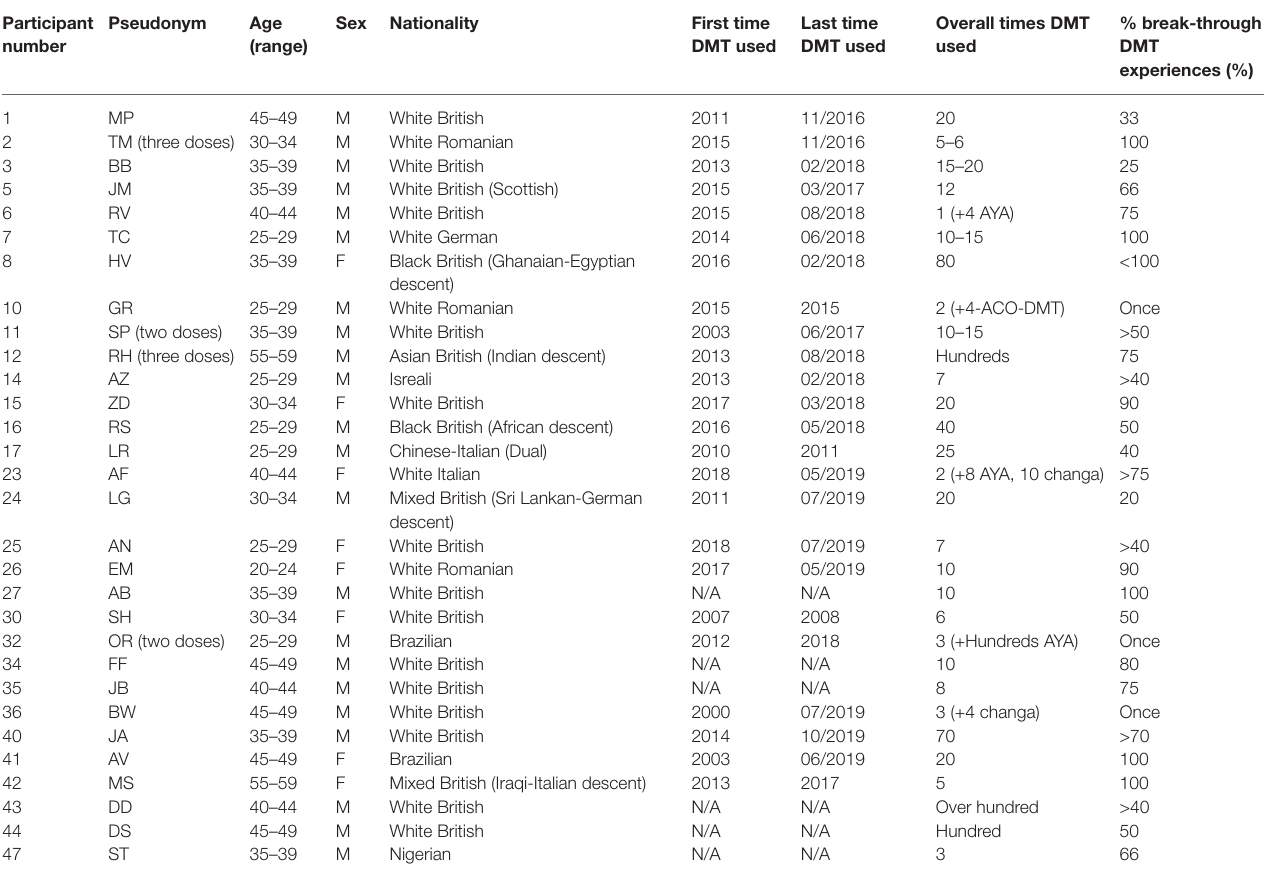
TABLE 1 | Participant demographics and DMT experience: average age, 37.4 (range: 23–58), eight female, 83% caucasian; AYA, ayahuasca; N/A, unprovided (free to withhold information due to illicit activity